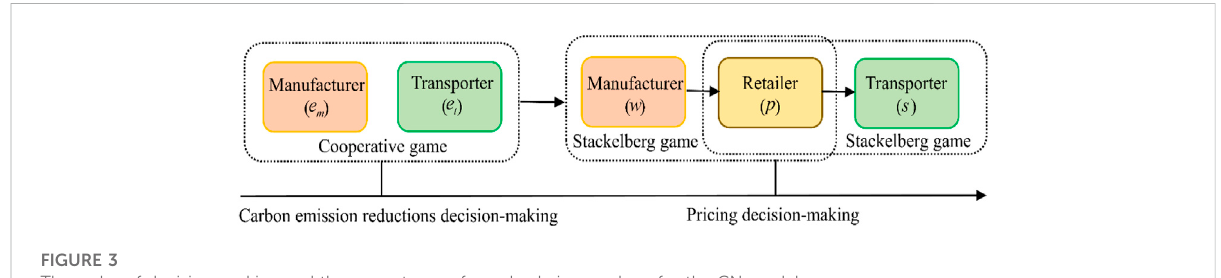
FIGURE 3 The order of decision-making and the game types of supply chain members for the CN